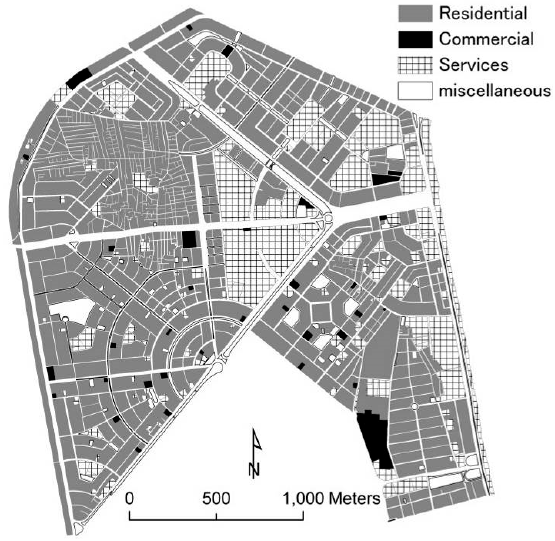
Figure 4. Shows land ‐ use in Boulaq.